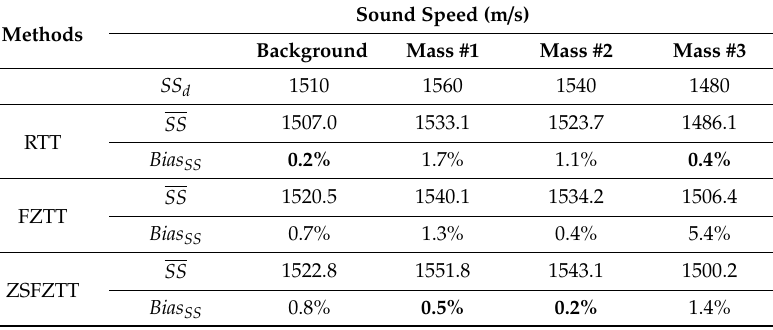
Table 2. The 𝐵𝑖𝑎𝑠 (cid:3046)(cid:3036)(cid:3053)(cid:3032) measured on SS image of numerical phantom reconstructed by RTT, FZTT, and ZSFZTT methods.